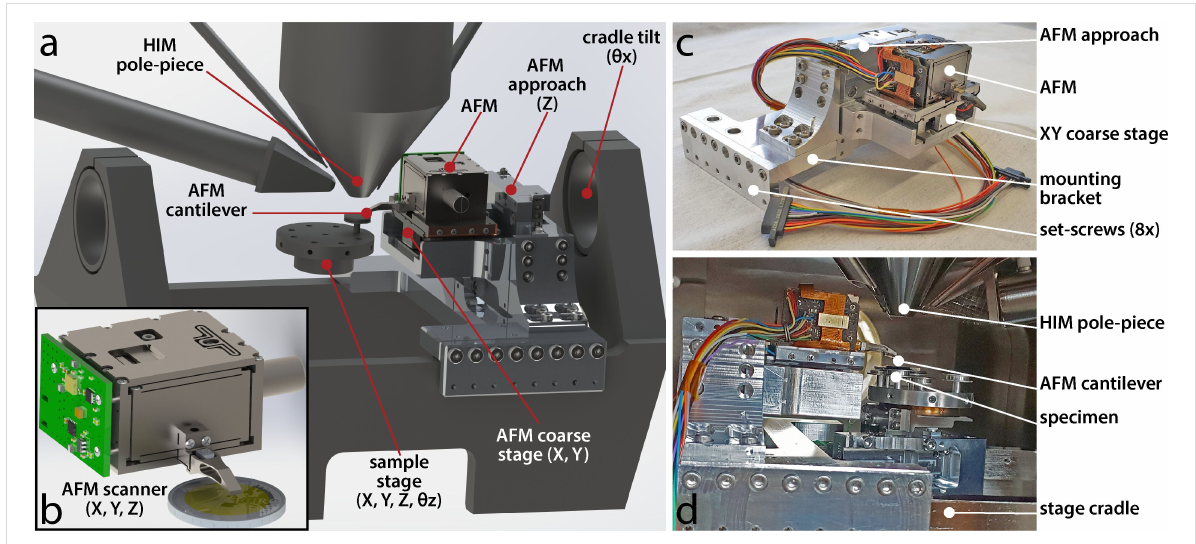
Figure 1: AFM assembly and integration inside a Zeiss ORION NanoFab helium ion microscope. a) Simplified CAD rendering of the AFM assembly mounted onto the HIM cradle and b) detailed view of the AFM scan head with a 2 EUR coin for scale. c) Annotated photograph of the AFM assembly and d) after being mounted inside the chamber of the